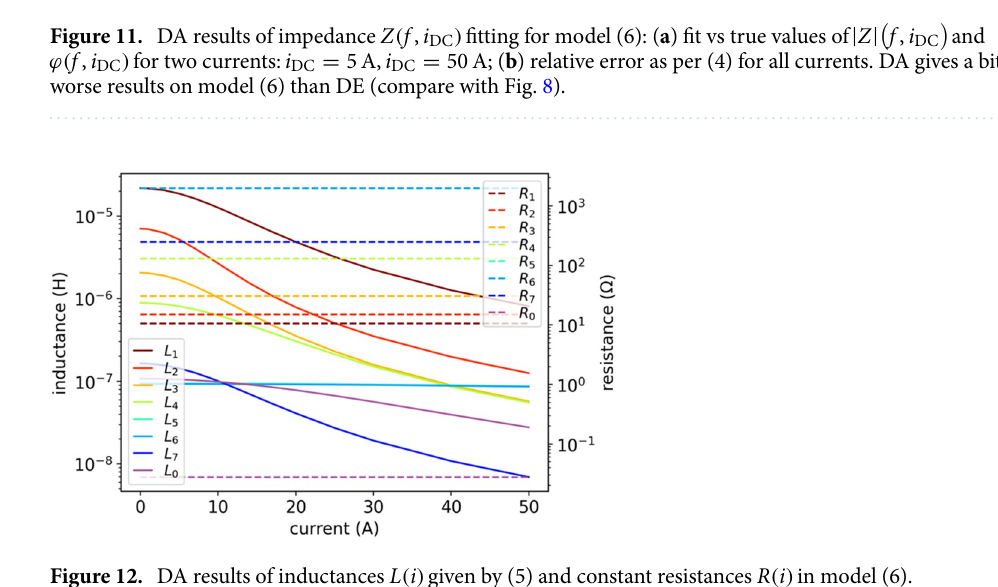
Figure 12. DA results of inductances L ( i ) given by (5) and constant resistances R ( i ) in model